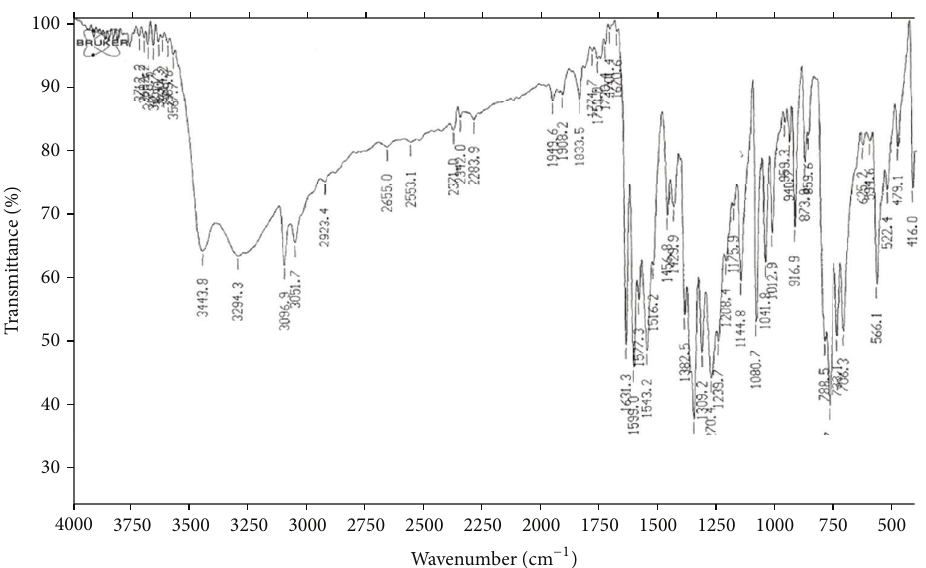
Figure 3: Infrared spectrum of naphtalene-1,4-diol and styphnic acid